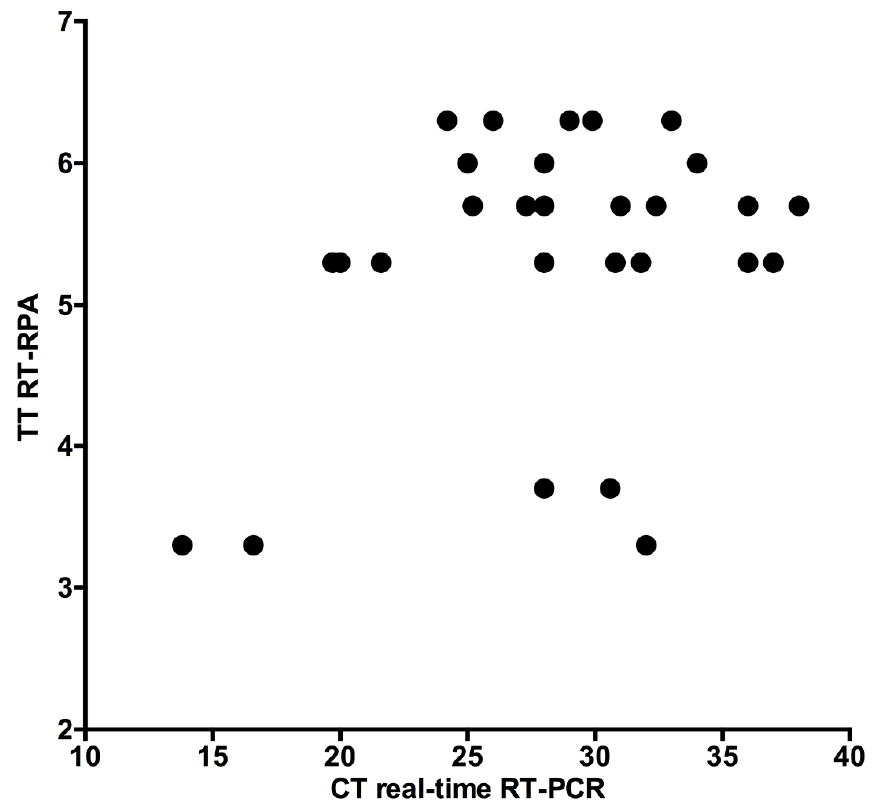
Figure 4. Validation of the RT-RPA assay on the clinical samples compared to real-time RT-PCR. H9 RT-RPA threshold times (TT, Y-axis) and real-time RT-PCR cycle threshold values (CT, X-axis) were compared by PRISM software. R squared (R2) value was 0.12. Independent of the CT values, RT-RPA assay detected all samples within 7 min.